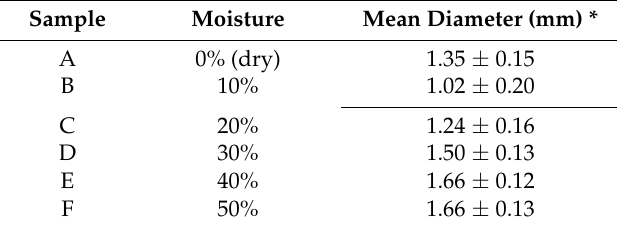
Table 1. Sauter mean diameter (mm) and deviation for each moisture (%) milling condition.